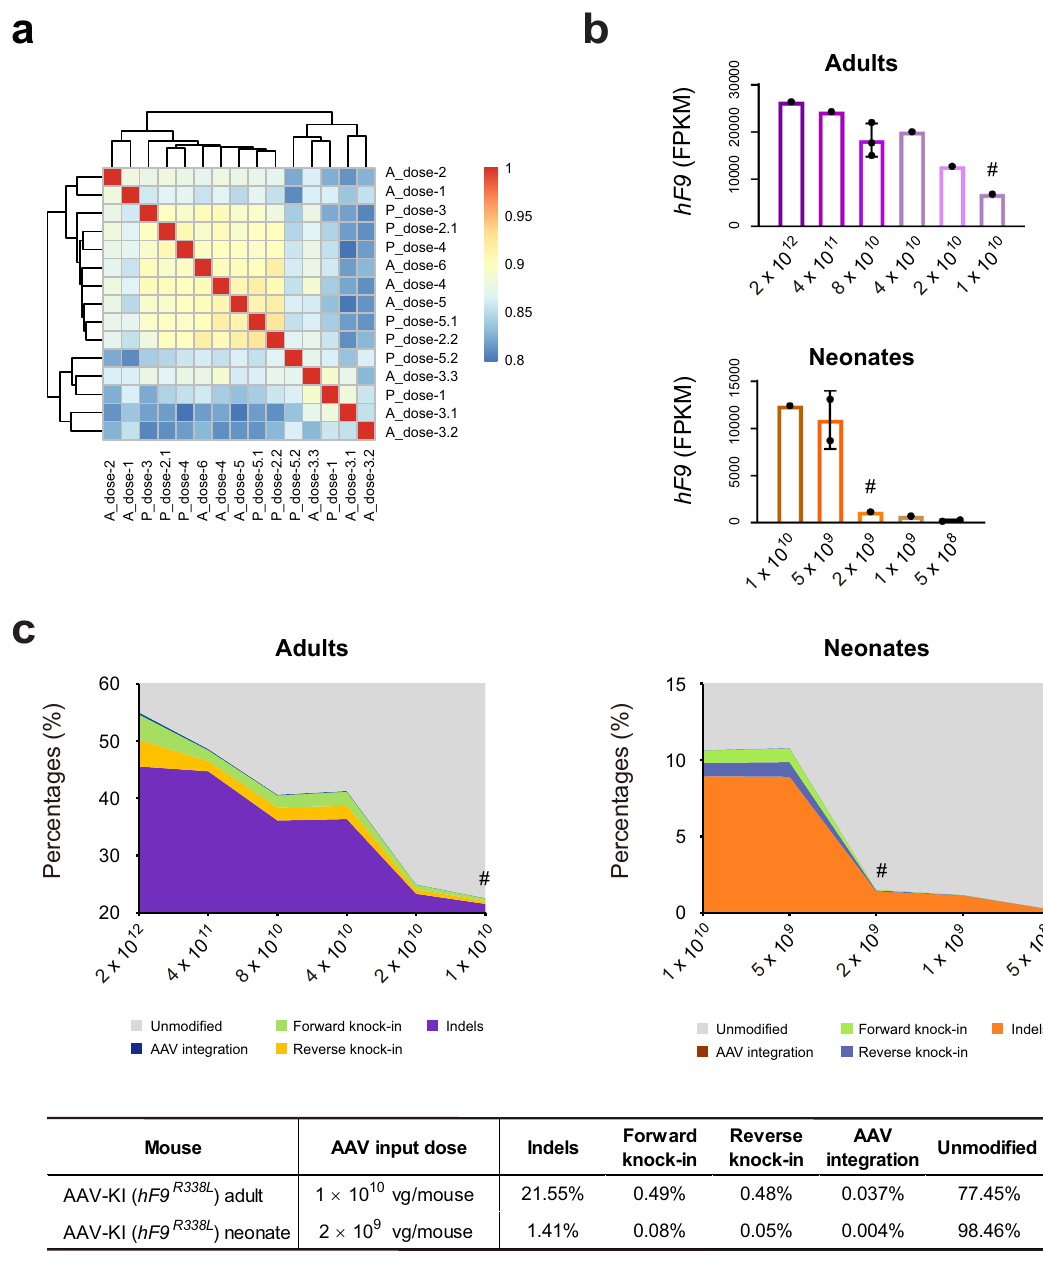
Fig. 6 | RNA-seq analysis for liver-speci fi c knock-inof hF9 R338L with various AAV input doses revealed much-reduced indel rates at a target site in neonatal mice. a Transcriptomic correlation heat mapbuilt with R valuesbasedon RNA-seq data of 15 liver samples collected from adult and neonatal AAV-KI ( hF9 R338L ) mice receivingvariousAAVdoses.DataarePearsoncorrelationcoef fi cients.Samplesand treatment conditions were shown in Supplementary Fig. 12. b Levels of hF9 R338L transcripts detected by RNA-seq among the adult (upper) and neonatal (lower) AAV-KI ( hF9 R338L ) liver samples examined in ( a ). Each dot represents one mouse sample. Data shown are mean±SD for adult mice receiving 8×10 10 vg/mouse ( n =3)andneonatesreceiving5×10 9 and5×10 8 vg/pup( n =2).Dataatotherdoses